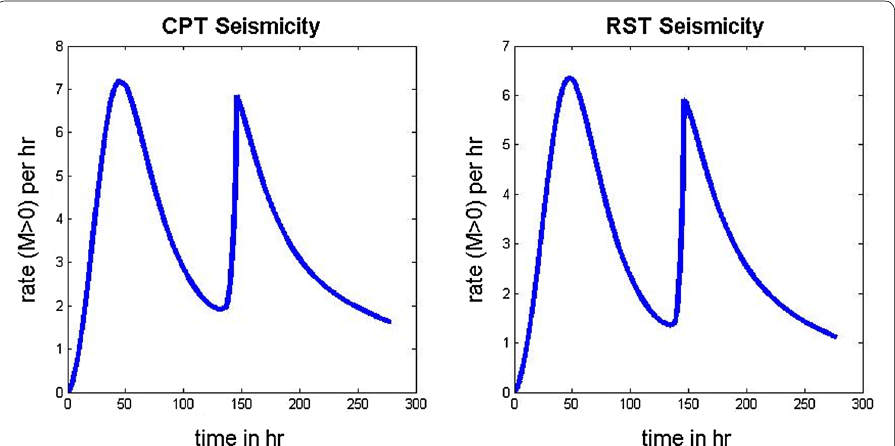
Fig. 3 Comparison of seismicity history calculated with CPT and RST for the two-cycle injection with D 0.1 m 2 /s and lower trigger threshold of 1 kPa for CP. The C RST value is also set to 1 kPa. There are no visible =